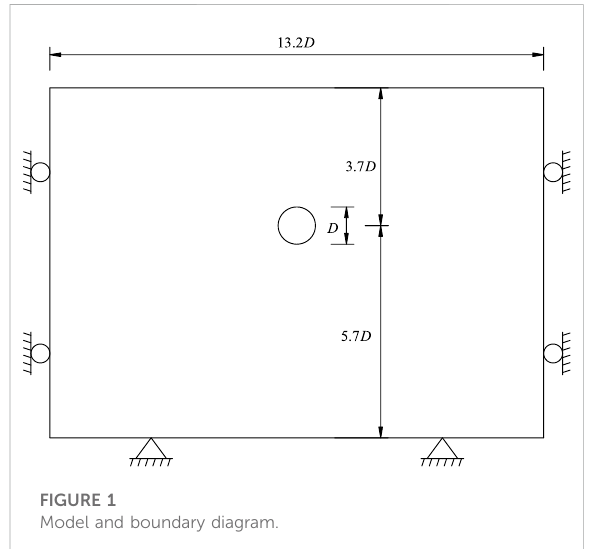
FIGURE 1 Model and boundary diagram.